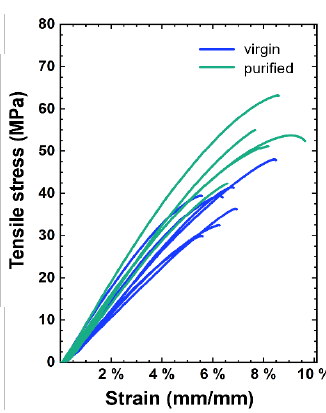
Figure A1. Effect of plasticizer loss on mechanical properties for commercial epoxy.